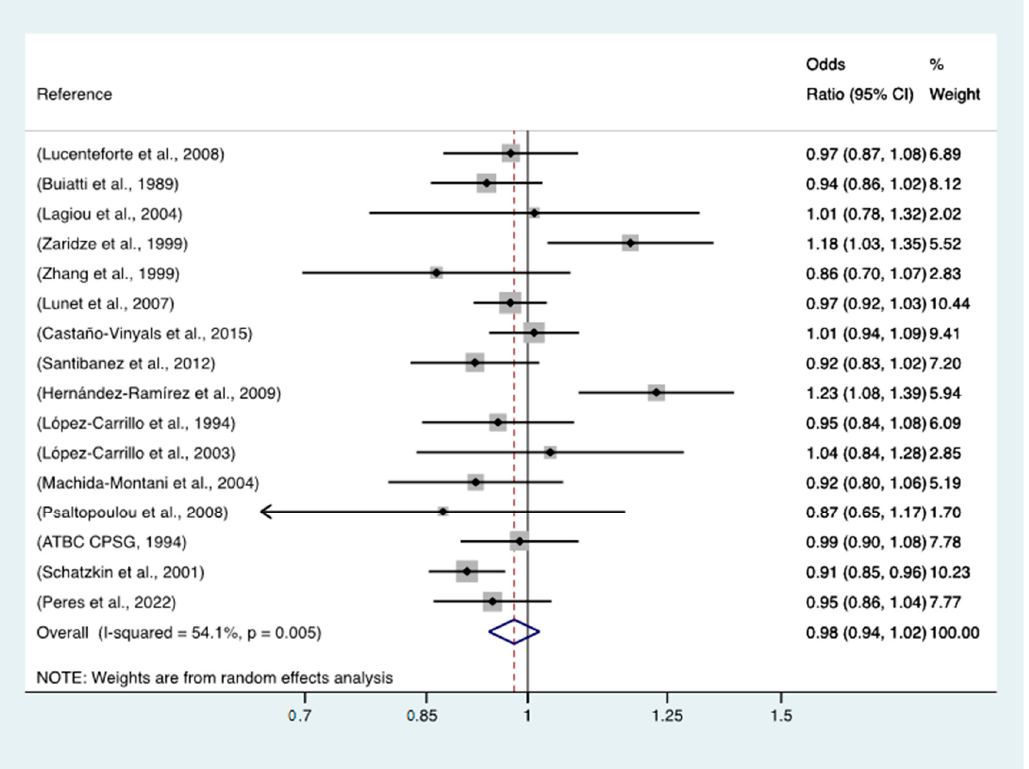
Figure 1. Results of a meta-analysis of the studies included. Notes: ATBC CPSG = The alpha- tocopherol beta carotene Cancer Prevention Study Group. Meta-analysis of the results for portions of yoghurt intake per week is continuous [17,18,20–33].